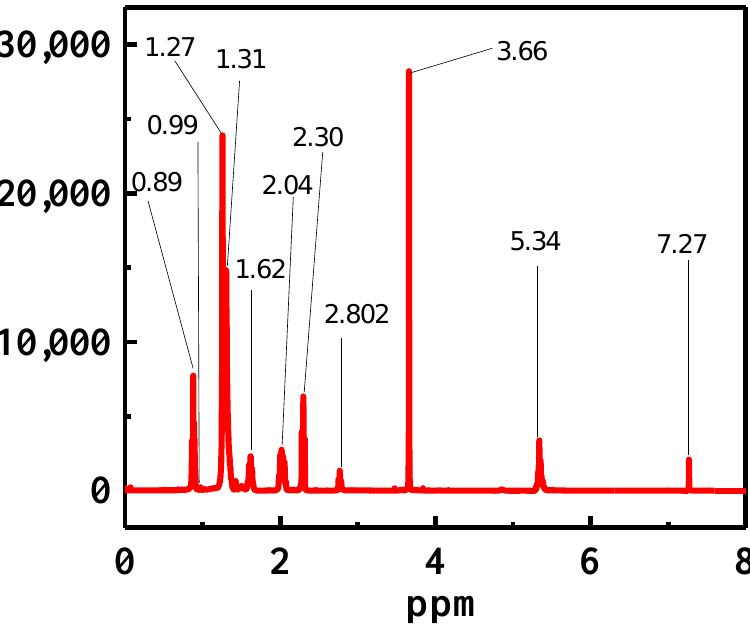
Figure 8. 1 H NMR spectrum shows RT FAMEs.